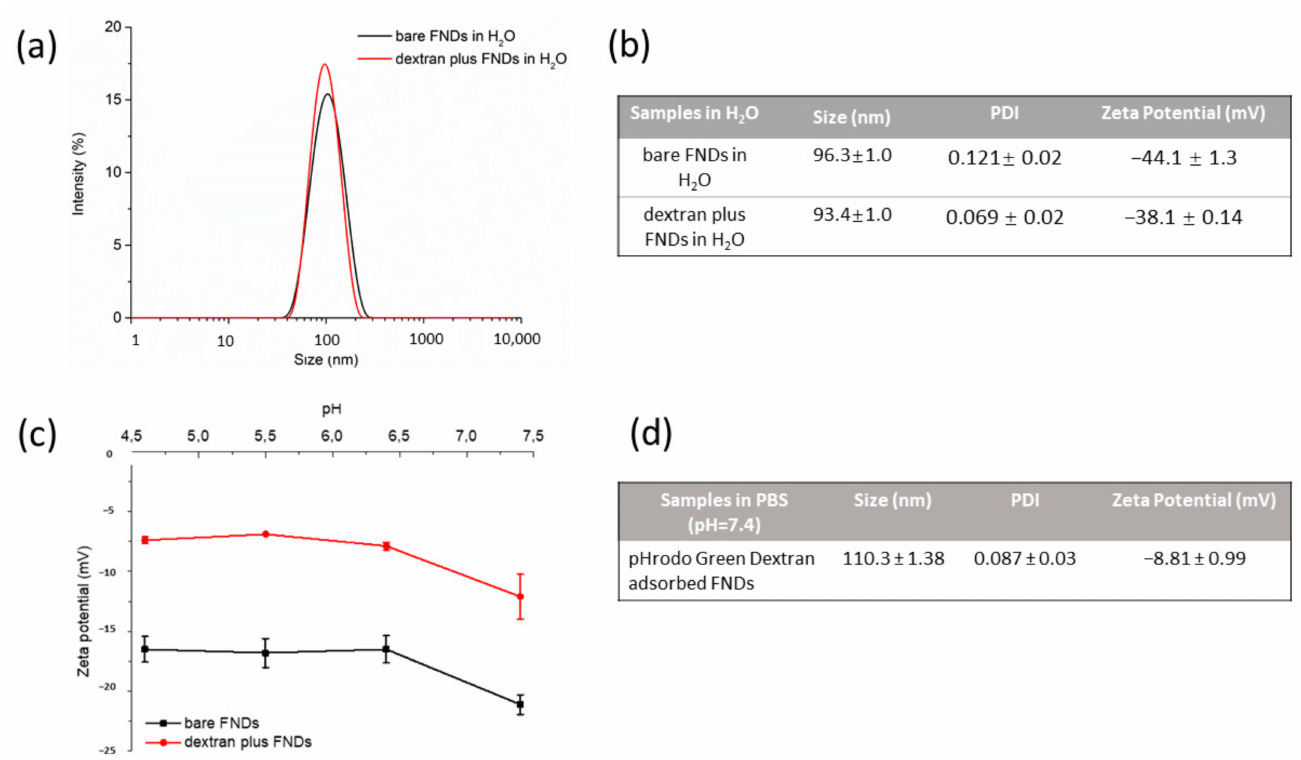
Figure 1. Characterization of 70 nm diamond particles. ( a ) Size distribution of bare FNDs and dextran-coated FNDs in water. ( b ) Size and zeta potential of bare FNDs and dextran-coated FNDs in water. ( c ) Zeta potential of bare FNDs and dextran coated FNDs in PBS at different pH. ( d ) Size and zeta potential of pHrodo Green dextran adsorbed FNDs in PBS at pH 7.4.